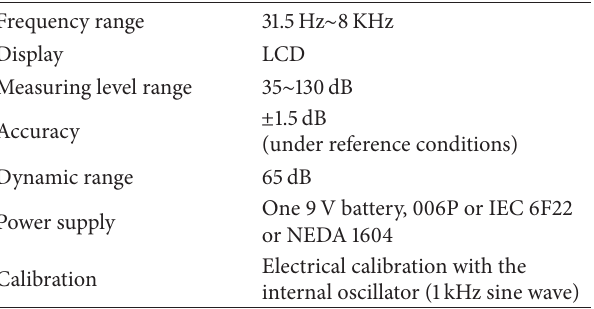
Table 12: Specifications of sound level meter.